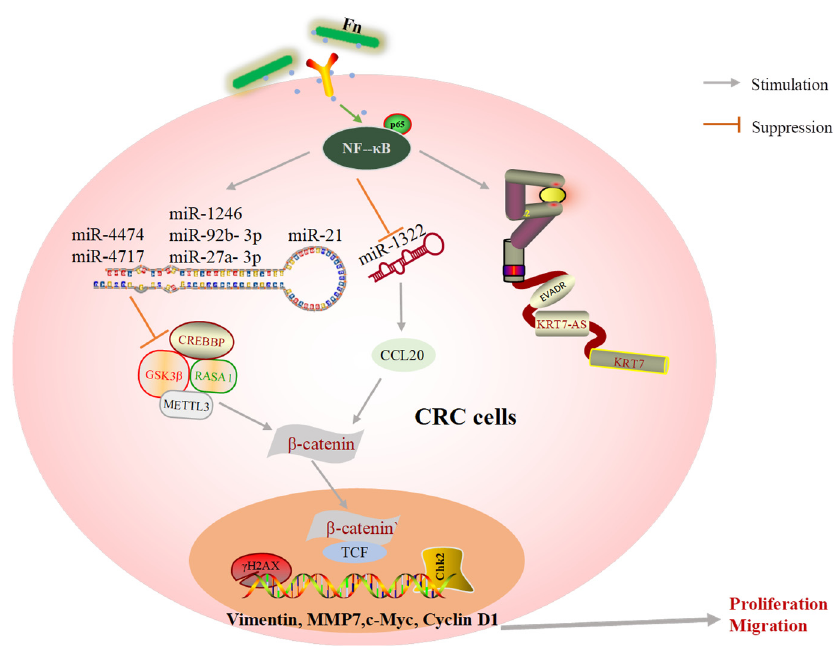
Figure 4. A schematic of oncogene expression regulated by Fn in CRC metastasis. In addition, the biological behaviors of host cells induced by Fn infection are transmitted through signaling pathways. Wnt/ β -catenin, TLR4/NF- κ B, IL-6/STAT3, autophagy, AKT/ERK, CXCL16/IL-8, and Hippo-YAP are classical signaling pathways derived from Fn infection and included in this review (Figure 5). The dysregulation of Wnt/ β -